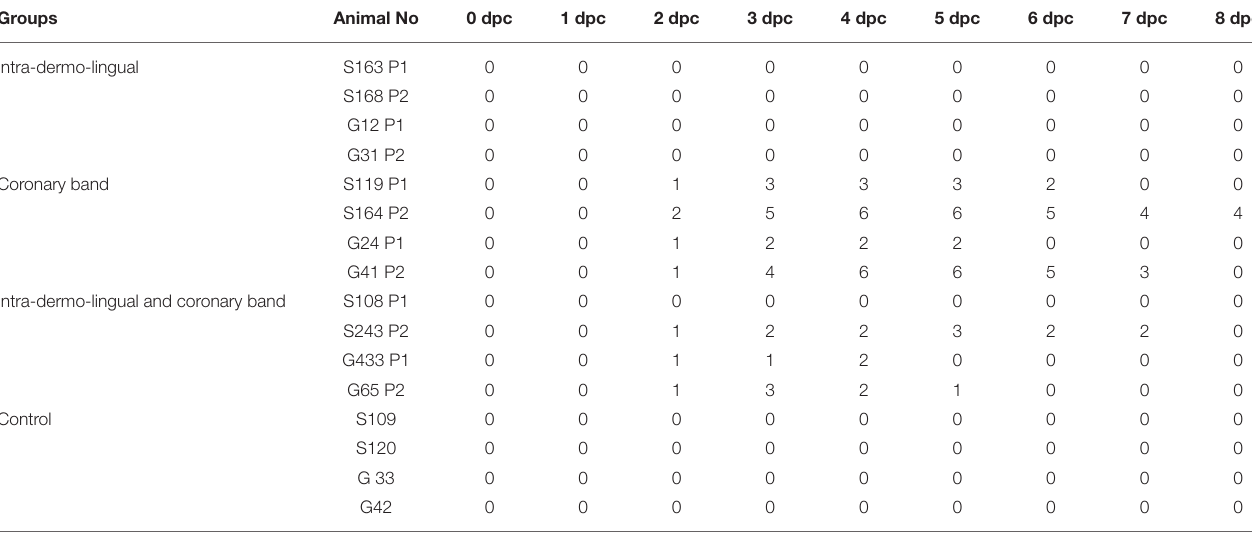
TABLE 1 | Lesion score of challenged and control sheep and goats. Groups Intra-dermo-lingual